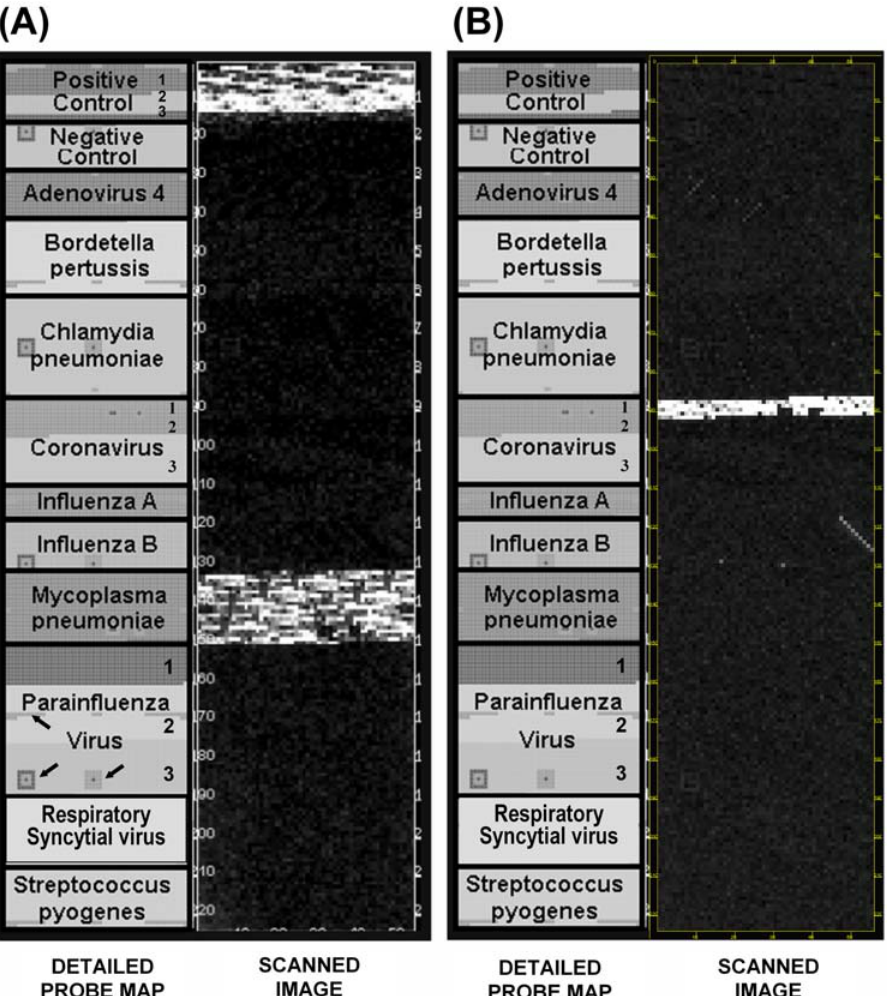
Figure 3. Pseudoimage of raw data from scanned chips illustrating Mycoplasmapneumoniae(A) and coronavirus 229E (B) detection. The left panels (Probe Map) show the position of all pathogen-specific probes and include 3 sub-type probes for coronavirus and parainfluenza virus. Geometric shapes indicated by arrows are areas on the microarray dedicated to array quality control probes. Positive control target was included only with M. pneumoniae (A). Coronavirus probes are divided into three sections on the array: 1) Type 1, 2) Type 2, and 3) Type 3.